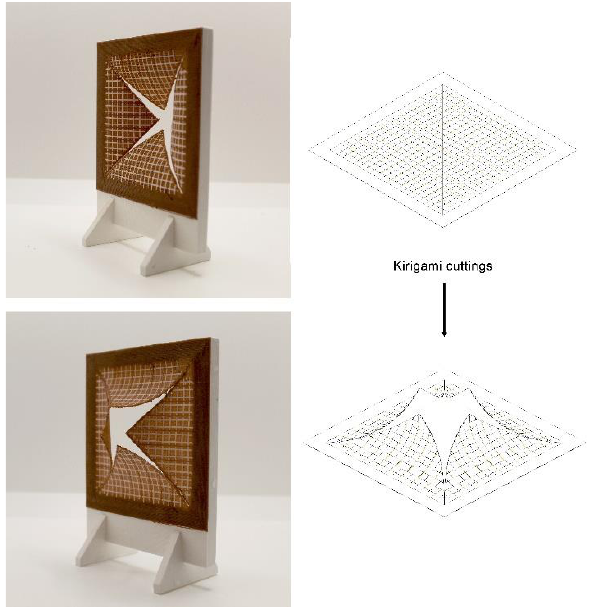
Figure 1 . The kirigami technique allows the mechanism to open and close for different levels of humidity.